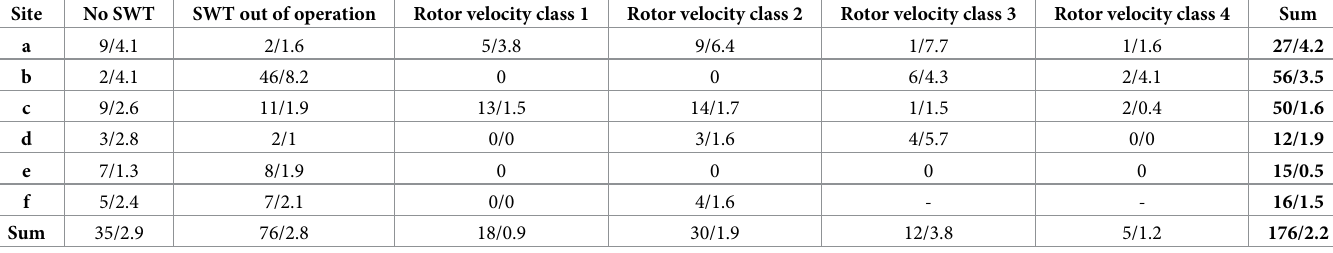
Table 2. Flight trajectories crossing the rotor blade diameter for the different operational modes and sites. Site No SWT SWT out of